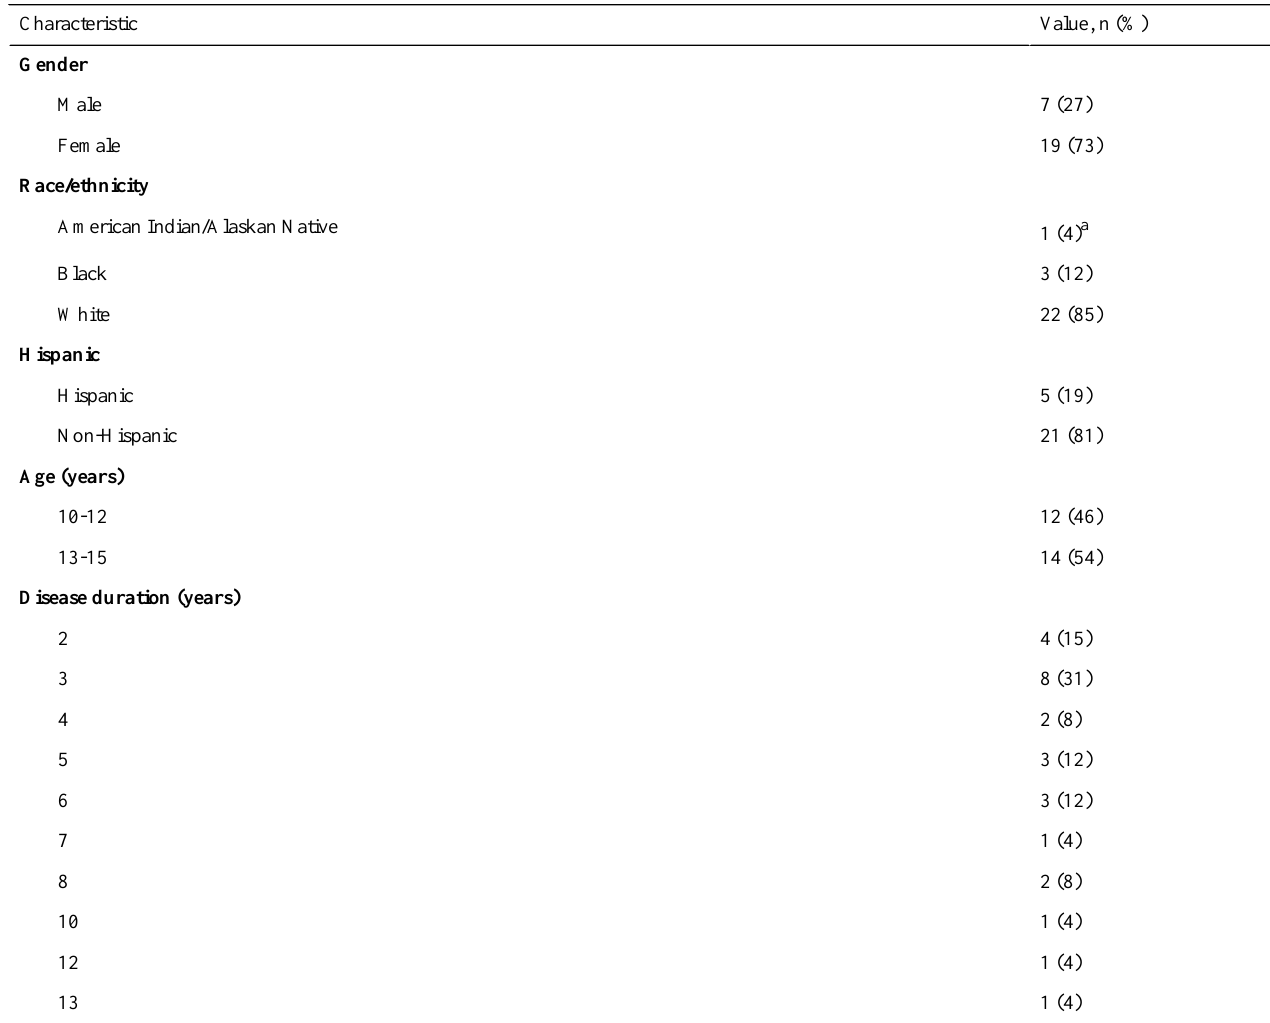
Table 5. Descriptive statistics of adolescents who completed the Diabetes Family Teamwork Online study